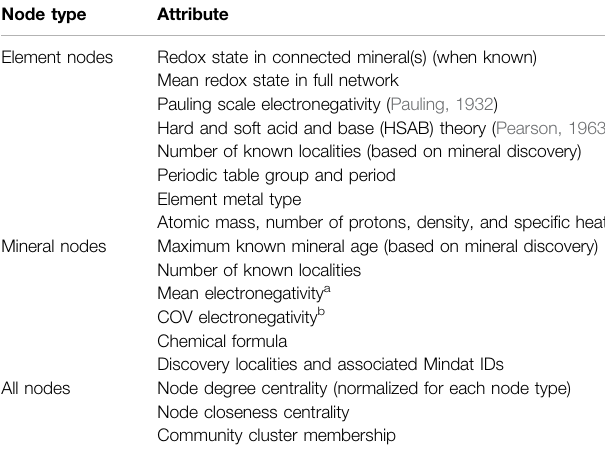
TABLE 1 | Node attributes available in